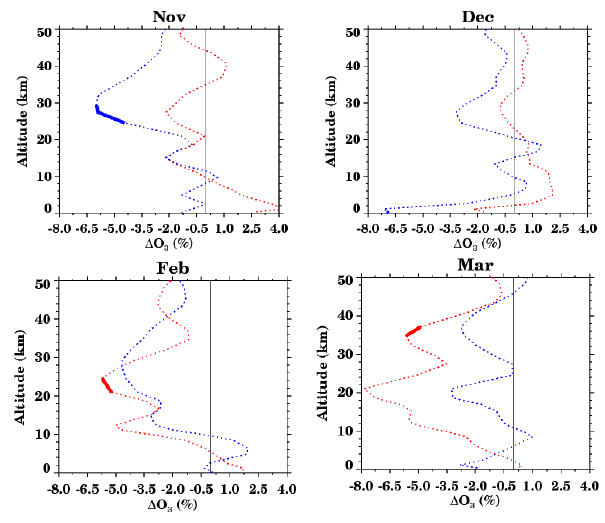
Fig. 8. GCR-induced effects on ozone, ([O 3 ] GCR - [O 3 ] control ) /[O 3 ] control , given in percent, for 70 ◦ –90 ◦ N. Upper panel: November and December; lower panel: February and March. Red lines: parameterization by Usoskin et al. (2010). Blue lines: parameterization by Heaps (1976). Thick solid lines: altitudes where the changes in ozone are significant at 95% level for the respective parameterization. Results are averaged from